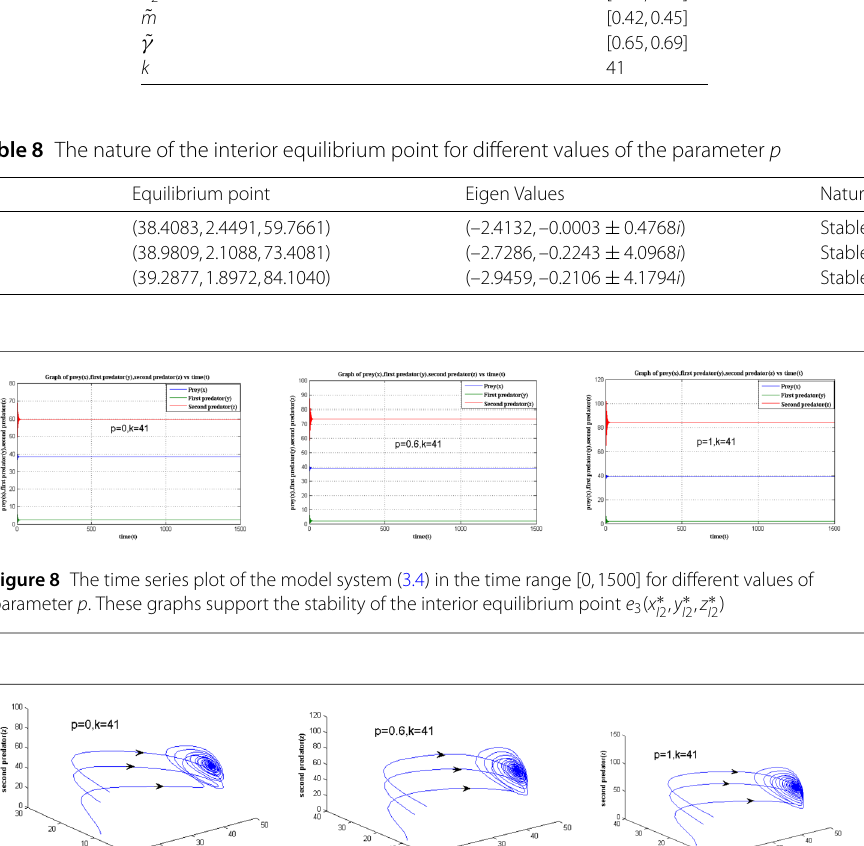
Figure 9 The model system (3.4) reaches the stable interior equilibrium point e 3 ( x ∗ values of the parameter p when numerical simulation is initiated from different initial points under the choice of model parameter values shown in Table